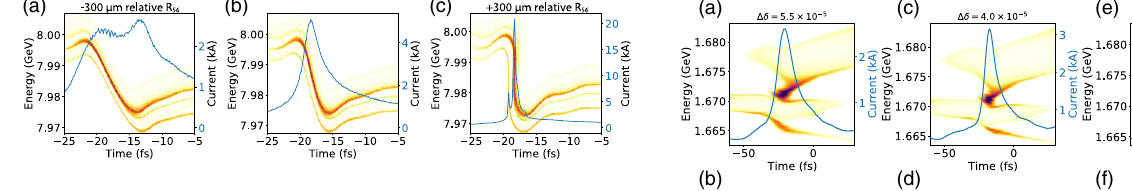
FIG. 4. The electron beam ’ s current profile can be controlled by varying the R 56 of DL2, the last dogleg before the undulator line. (a) (b) and (c) show the longitudinal phase space of electron beam at the start of hard x-ray undulator line with − 300 μ m, 0 μ m, and þ 300 μ m DL2 R 56 respectively. FIG. 6. Longitudinal phase space of electron beam after BC2 (a,c,e) and the start of hard undulator line (b,d,f) with different nominal laser heater – induced energy spreads specified above (a, c,e) relative to the beam energy in the laser heater.